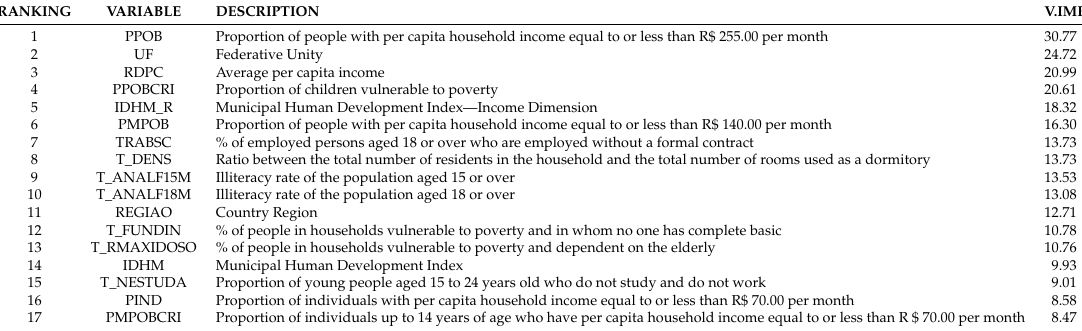
Table 6. Variables Importance in the classification